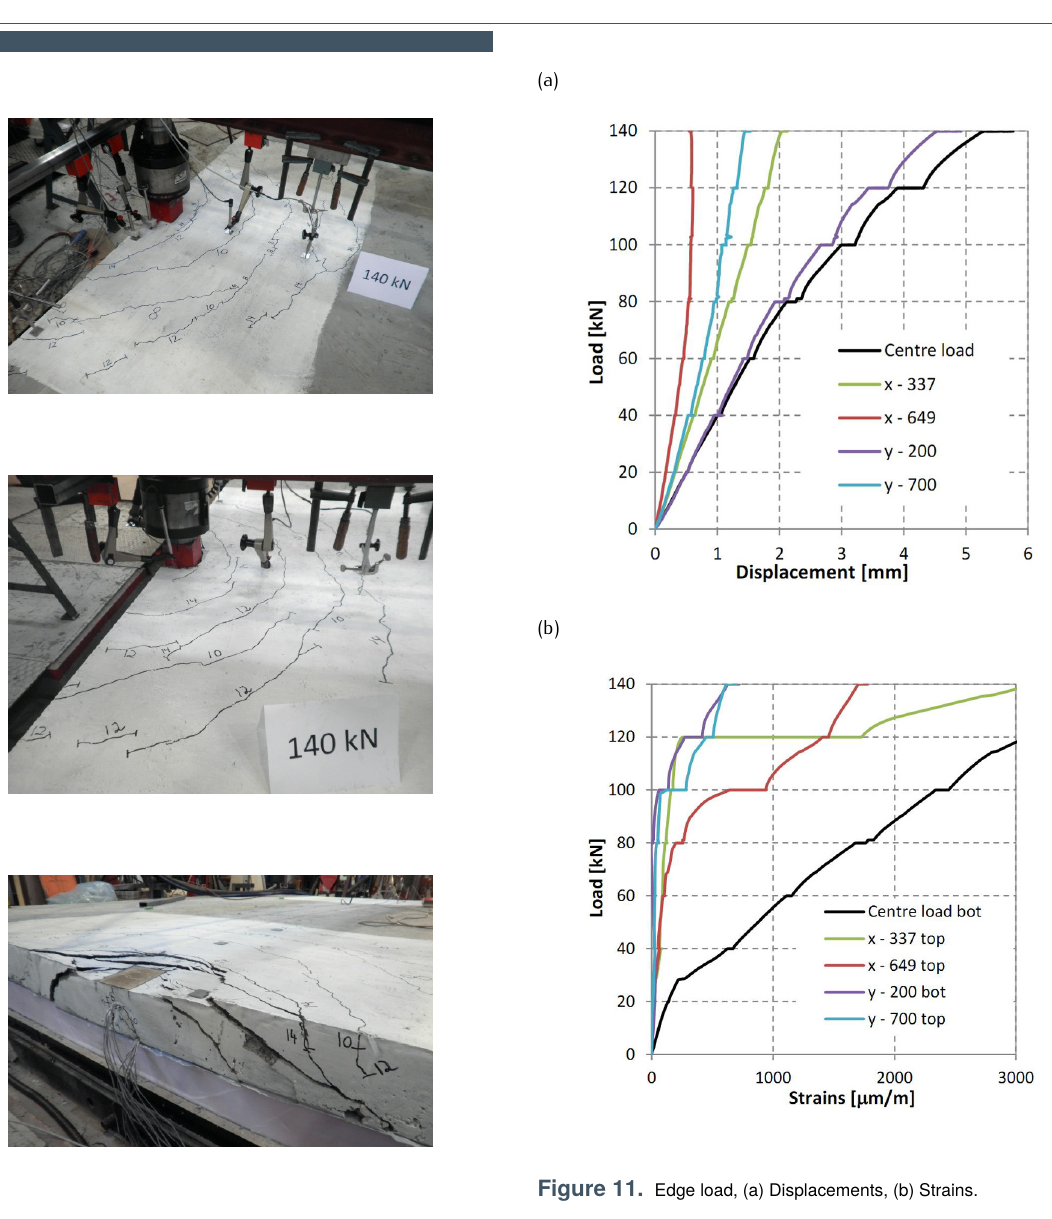
The load-displacement graphs exhibited in Figure 13a, shows that corner load gives a local response. The radius of relative stiffness, l , for the slab, using the measured modulus of elasticity is 404 mm; at a distance of 1 . 0 l from the loaded area, the deformation is halved. The strains in Figure 13b clearly indicate cracking at a load of approximately 35 kN, which corresponds to the observed